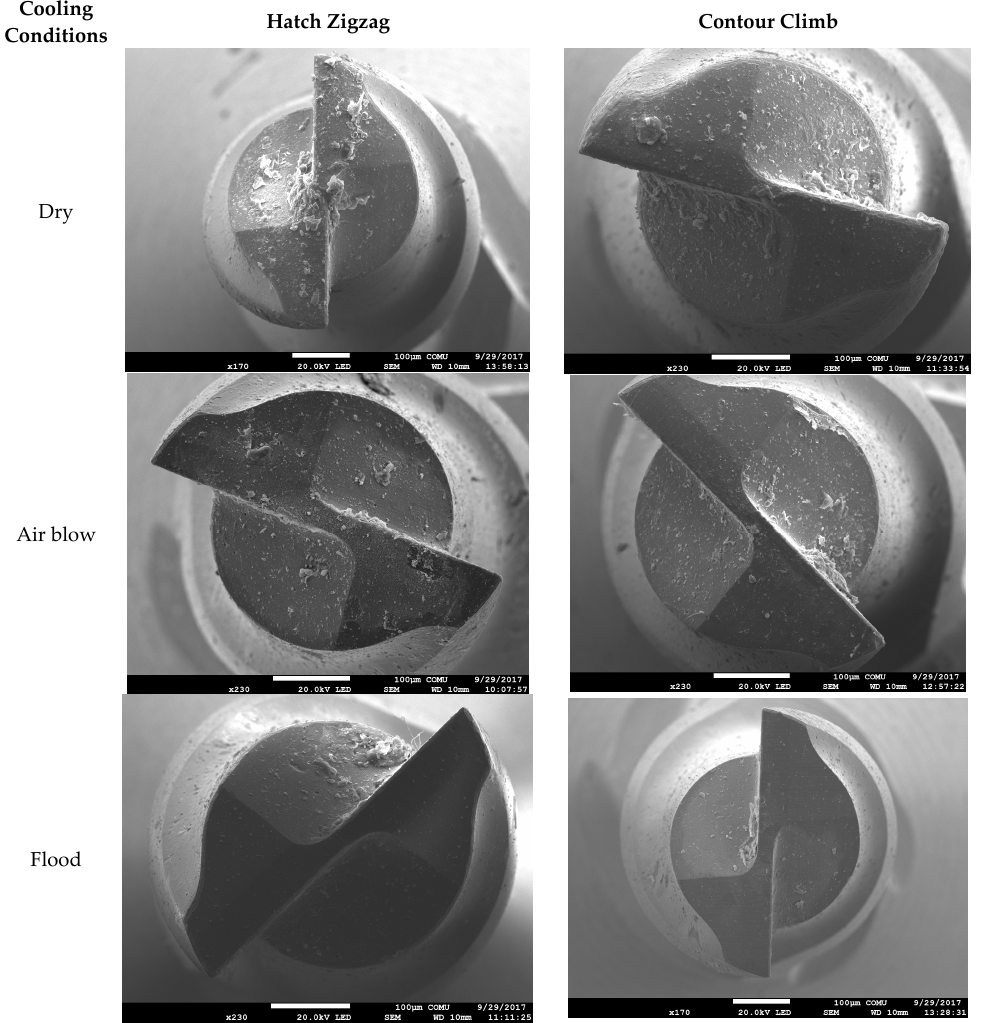
Figure 8. Comparison of tool wear obtained with different milling strategies.